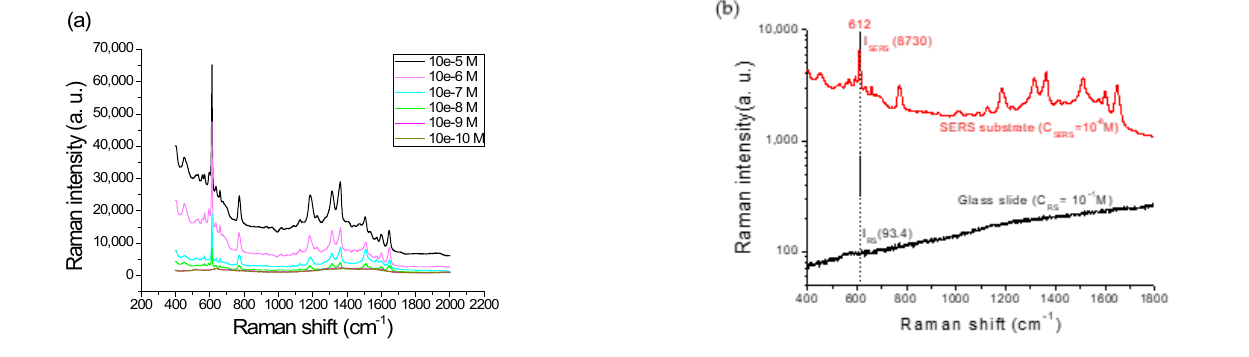
Figure 9. ( a ) The SERS intensities with R6G concentration between 10 − 5 to10 − 10 M in Sample C. The limit of detection (LOD) observed was lower at 10 − 8 M. ( b ) A comparison of the Raman spectra between Sample C for measuring the 10 − 6 M R6G analyte and a pure glass slide for 10 − 1 M.